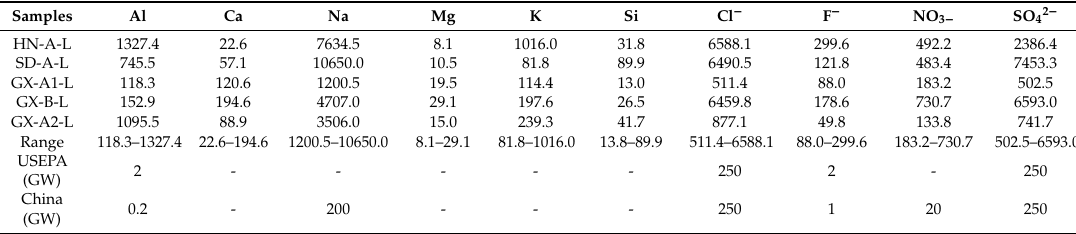
Figure 3. Boxplot of the concentration of major elements / ions in red mud leachate (Red lines indicates the MCLs of groundwater quality standards). Table 6. The concentration of major elements (ions) in the red mud leachate (mg / L).